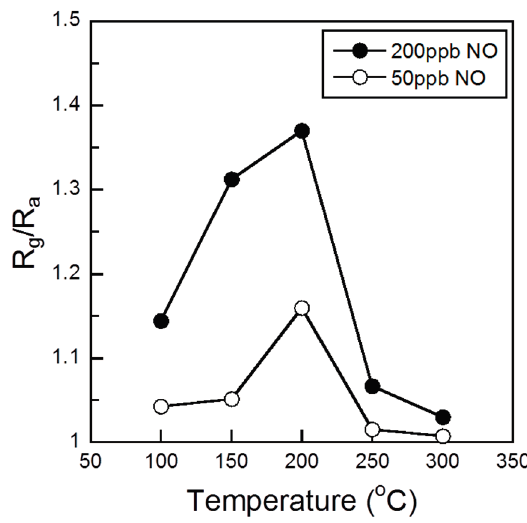
Figure 4. Sensor responses of the sensor element using a 10%Pd/Co 3 O 4 powder to 50 and 200 ppb NO as a function of the operating